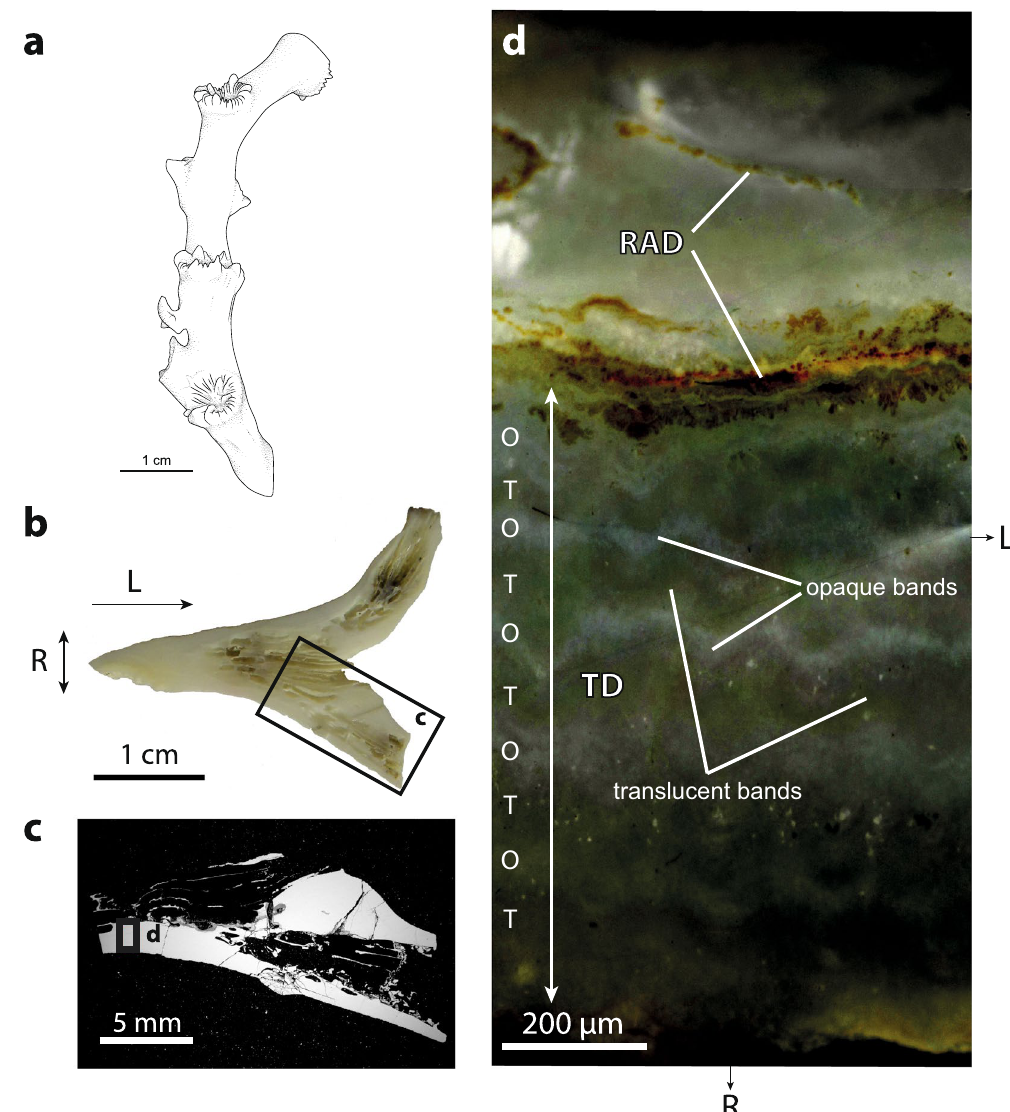
Figure 1. Skeletal architecture of L. pertusa . ( a ) Sketch showing a typical branch of L. pertusa formed by a succession of corallites. Light ( b ) and electron ( c ) micrographs of the area of investigation. ( d ) Reflected- light image of the area highlighted in (c) displaying a thick rapid accretion deposit (RAD) area running horizontally across the view, and a thinner RAD lamella in the internal part of the corallite wall. Smaller roughly equidimensional RADs (not shown, s. Fig. 2) are also present within the thickening deposit (TD). Alternation of opaque (O) and translucent (T) bands can be distinguished in the TD area. Radial and longitudinal growth directions are indicated by R and L, respectively. Artwork 1a by A. Lethiers, used with